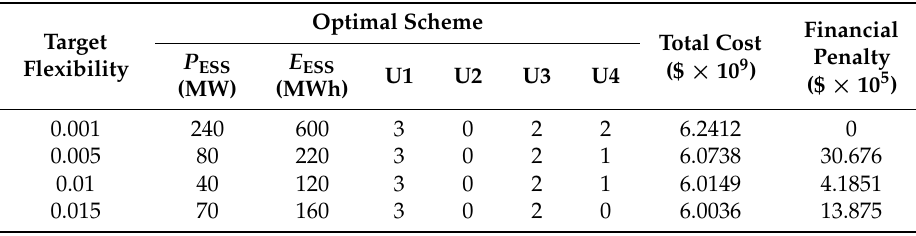
Table 8. Results on the impact of target